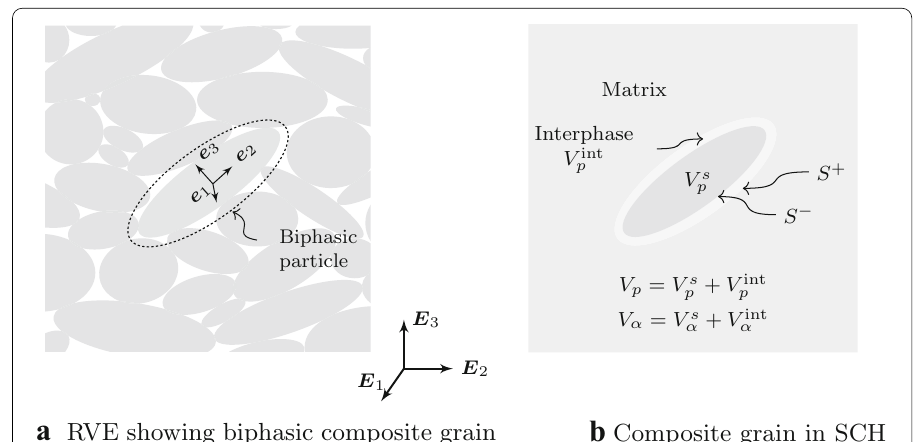
Fig. 1 Granular assembly: a slice through a representative volume element (RVE) showing local porosity and imperfect interface associated with a grain; b treatment of a grain within SCH scheme having imperfect interface represented as an interphase layer with thickness of grain’s local porosity, such that changes to it translate to changes in porosity. Adapted from Bennett et al.